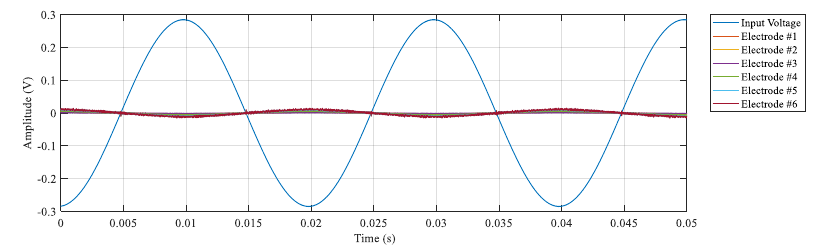
Figure 9. Measured voltage from the monitor and the electrodes, joint #1.